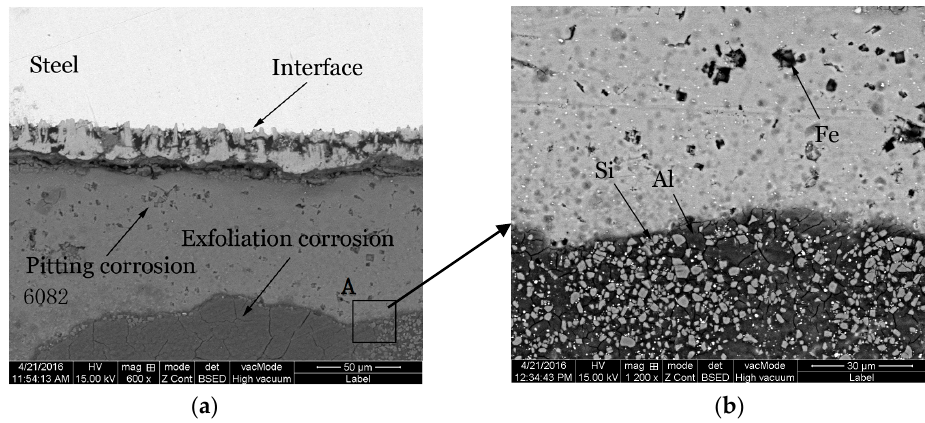
Figure 4. ( a ) The microscopic corrosion morphology of the transverse section of keyhole-free FSSW joints after immersion for 48 h. ( b ) The elements at the interface and interfacial layer.